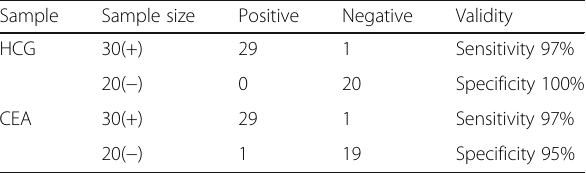
Table 1 Clinical test of HCG and CEA